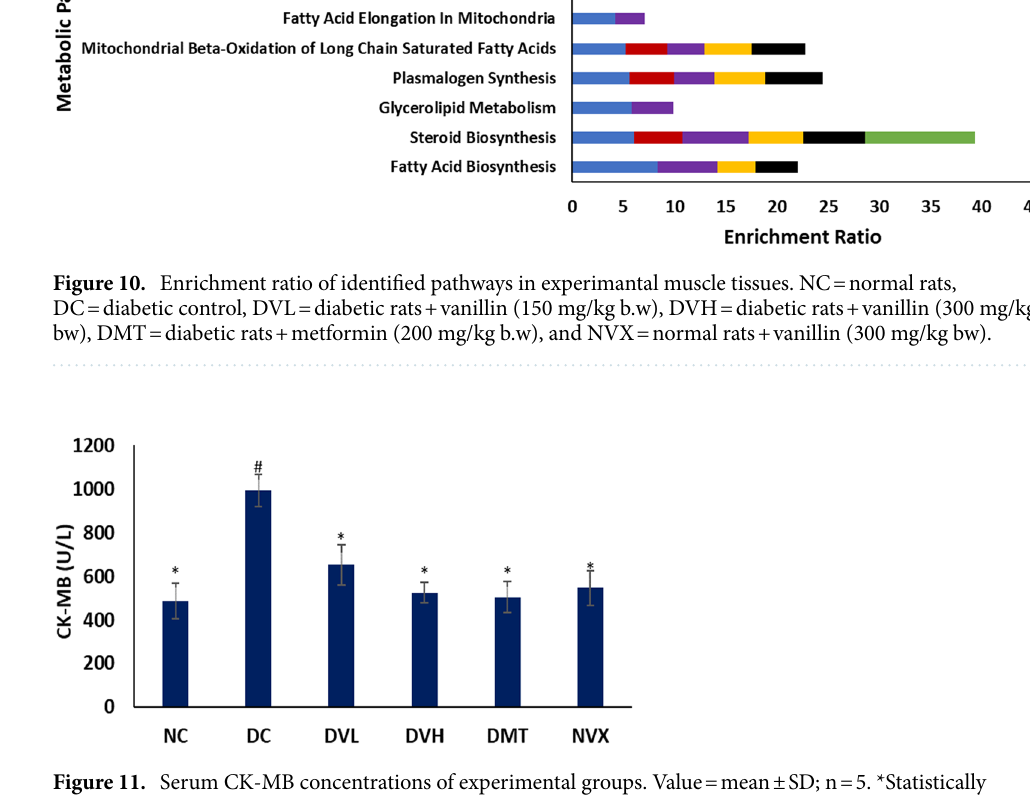
Figure 11. Serum CK-MB concentrations of experimental groups. Value = mean ± SD; n = 5. *Statistically significant ( p < 0.05) to DC; #Statistically significant ( p < 0.05) to NC. NC = normal rats, DC = diabetic control, DVL = diabetic rats + vanillin (150 mg/kg b.w), DVH = diabetic rats + vanillin (300 mg/kg bw), DMT = diabetic rats + metformin (200 mg/kg b.w), and NVX = normal rats + vanillin (300 mg/kg